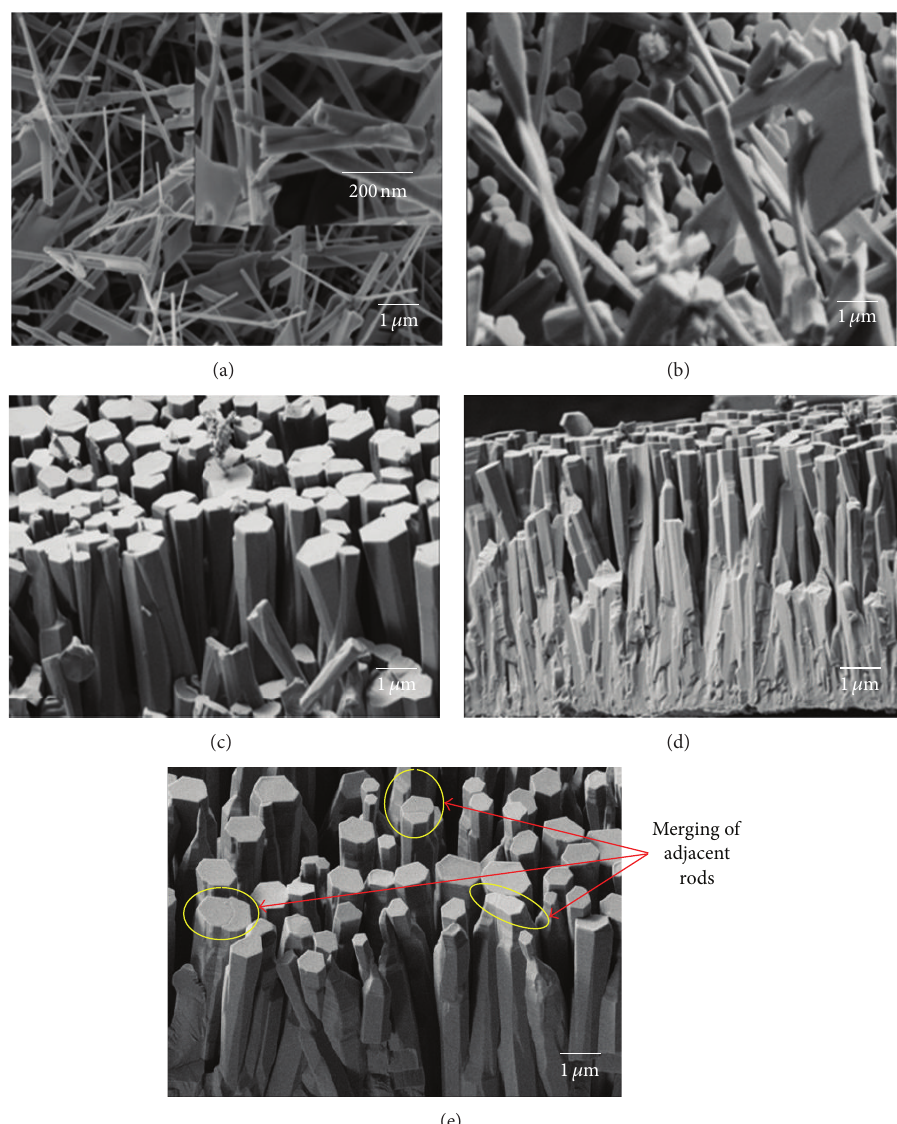
Figure 5: Effect of amount of Zn powder on the growth of ZnO NRs on stainless steel wire: (a) 0.3 g, (b) 0.5 g, (c) 1.0g, (d) 1.5 g, and (e) 2.0 g, respectively, (650 ∘ C and 2sccm O 2